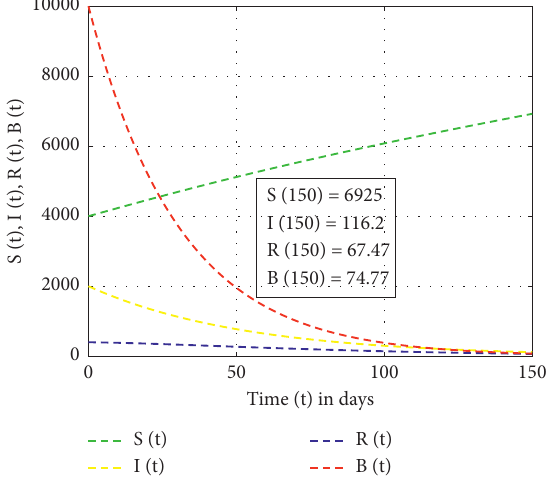
Figure 3: Simulation of the SIR-B model with weak control measures ( u